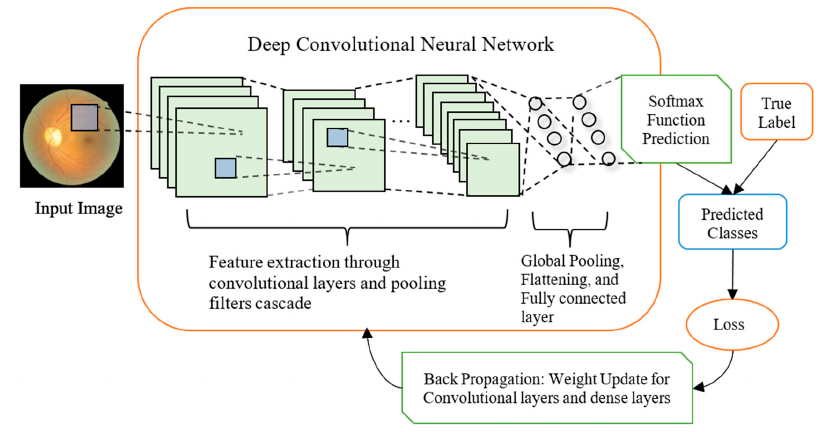
Figure 1. Illustration of classification methodology and deep CNN training process: The input image is analyzed by convolutional filters (Blue squares) which apply to a small receptive field but detecting at each of the image positions and always extending through the whole depth of the image. The resulting output feature maps (Green Squares) are analyzed by convolutional layers or pooling filters at each of their surface positions until being processed by a global average pooling layer which is followed by one fully connected layer. Each green square represents a feature map corresponding to the output for one of the learned features. The convolutional neurons are activated using ReLU function, while the final layer connects to a Softmax function which converts the output into probabilities of the input image belonging to different categories. For training, the true label joins the predicted classes for calculating loss using object function which is cross entropy in our case. The losses are then backpropagated through the network for updating weights of convolutional filters and fully connected layer, where stochastic gradient descent was used for updating weights.